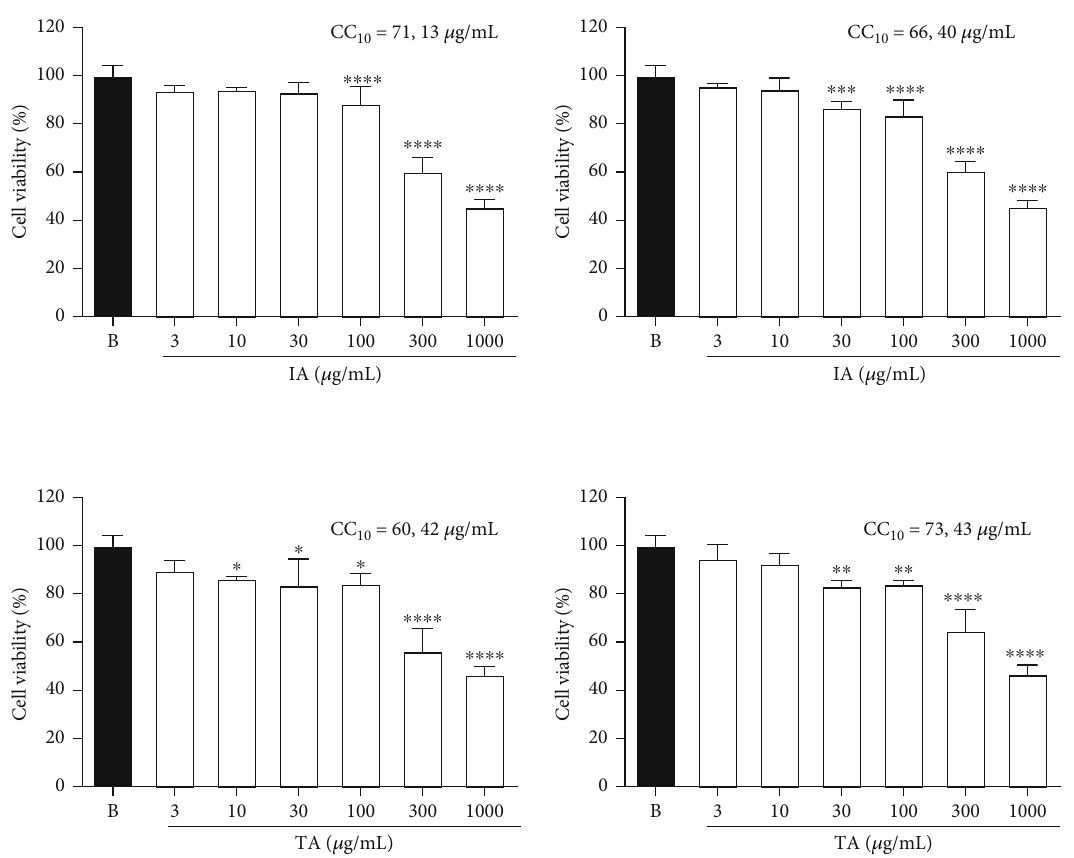
Figure 5: E ff ect of Ilex paraguariensis extracts (IA, IE, TA, and TE) on cytotoxicity of RAW 264.7 cells. B: untreated cells. Results were expressed as mean ± SEM ; n = 3 ; ∗ p < 0 : 1 , ∗∗ p < 0 : 01 , ∗∗∗ p < 0 : 001 , and ∗∗∗∗ p < 0 : 0001 vs. group B. IA: aqueous infusion; IE: ethanolic infusion; TA: aqueous turboextraction; TE: ethanolic as well as by CAF at 0.52 μ M (% inhibition: 26 : 45 ± 5 : 34 ) secretion was signi fi cantly decreased by THEO tested at ( p < 0 : 0001 ) and RUT at 0.16 μ M (% inhibition: 40 : 18 ± 0.033 μ M (% inhibition: 22 : 15 ± 6 : 49 ) ( p < 0 : 0001 ), NCA at 3 : 70 ) ( p < 0 : 0001 ). The concentration of each compound 1.97 μ M (% inhibition: 27 : 46 ± 3 : 98 ) ( p < 0 : 0001 ), CCA at used in these experiments represents the amounts of each 0.35 μ M (% inhibition: 39 : 76 ± 5 : 73 ) ( p < 0 : 0001 ), and one in the IA at the lower concentration tested (3 μ g/mL). CGA at 0.56 μ M (% inhibition: 23 : 58 ± 5 : 79 ) ( p < 0 : 0001 ),